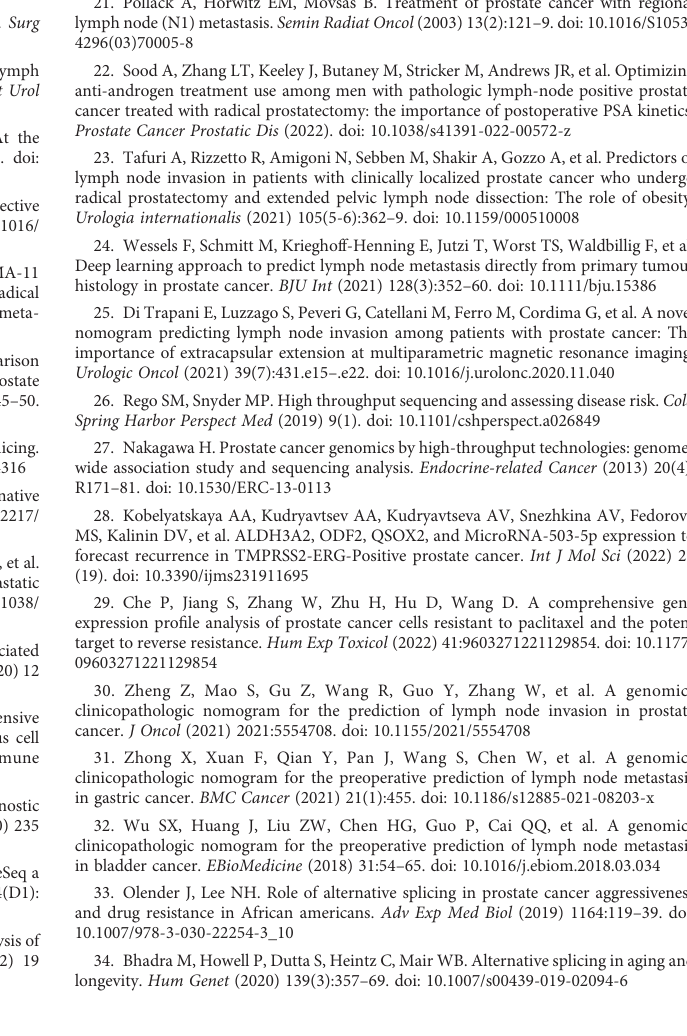
PRAD patients. (D) UpSet plot of intersections among seven types of DEAS events associated with lymph node metastasis in the PRAD patients. (E) Number of DEAS events and corresponding parent genes. ( F ) Pie chart of composition ration of seven DEAS events. (G) The top 50 DEAS were shown in the heatmap. SUPPLEMENTARY TABLE 1 Training set and validation set SUPPLEMENTARY TABLE 2 The results of differential analysis of alternative splicing. SUPPLEMENTARY TABLE 3 The 96 AS with their corresponding non-zero coef fi cients from LASSO results. SUPPLEMENTARY TABLE 4 The performance of the eight classi fi ers in the training set with fi ve-fold